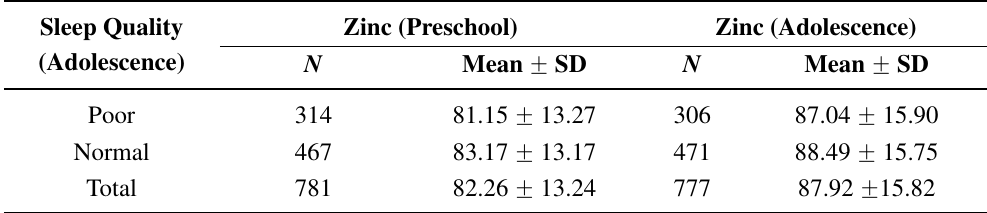
Table 2. Preschool a and adolescent b blood zinc concentrations c by adolescent sleep